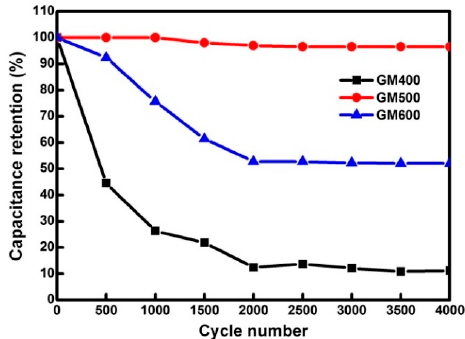
Figure 6. Cyclic stability of GM 400 , GM 500 , and GM 600 at a current density of 1.0 A g − 1 .